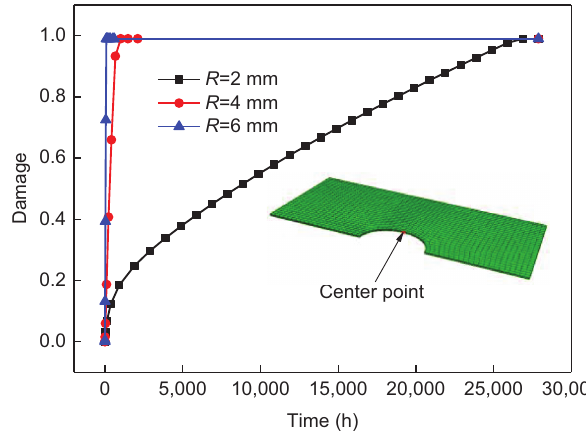
Figure 9: The creep damage variation with time for different defect radii.